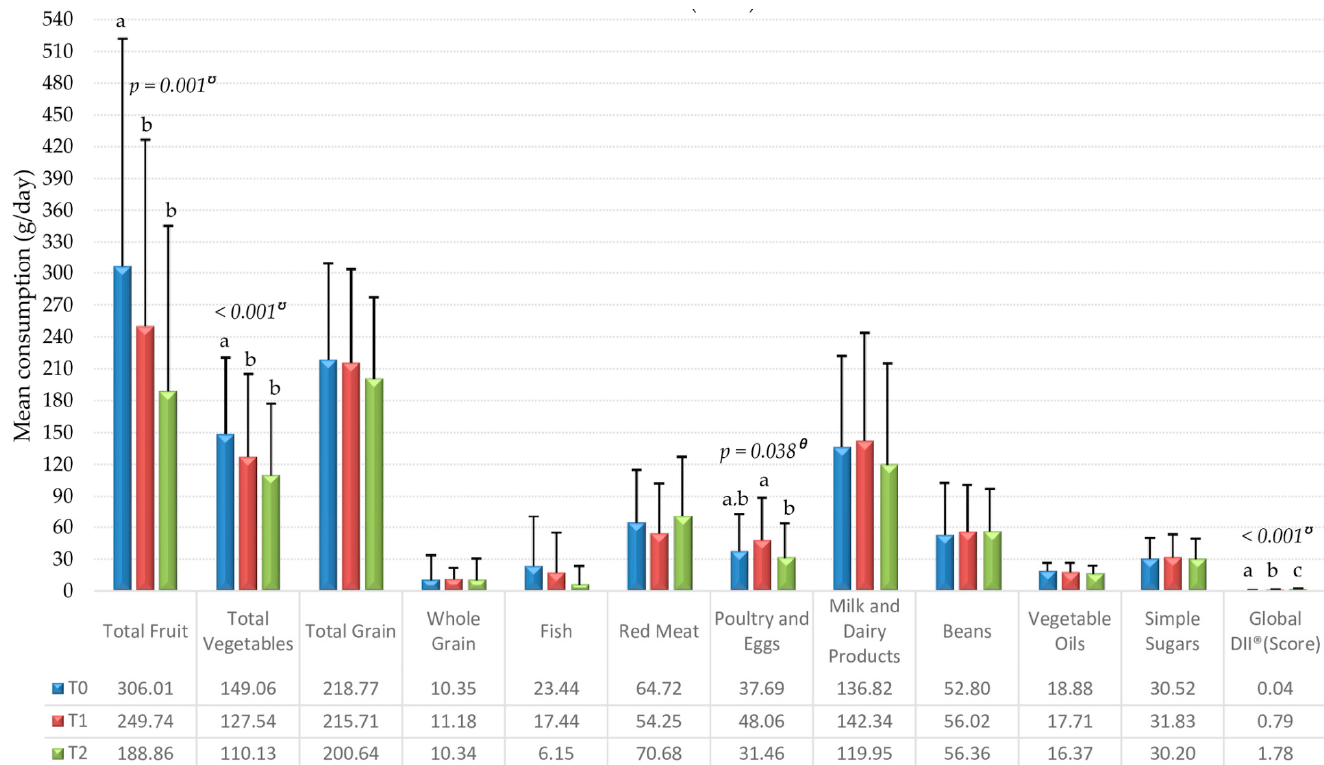
Figure 1. Consumption of food groups (g/day) and dietary inflammatory index (DII ® ) of women with breast cancer in chemotherapy (CT) attended at Clinics Hospital at Federal University of Uberlandia, Minas Gerais, Brazil, 2014 – 2015 ( n = 55). T0, period after the administration of the first cycle of CT; T1, period after administration of the intermediate cycle; T2, period after administration of the last CT cycle; ᶿ One-way ANOVA with repeated measures + Bonferroni post-hoc; ᶷ Friedman + Multiple comparisons test; Means horizontally followed by different letters differ statistically as post-hoc test at 5% probability.